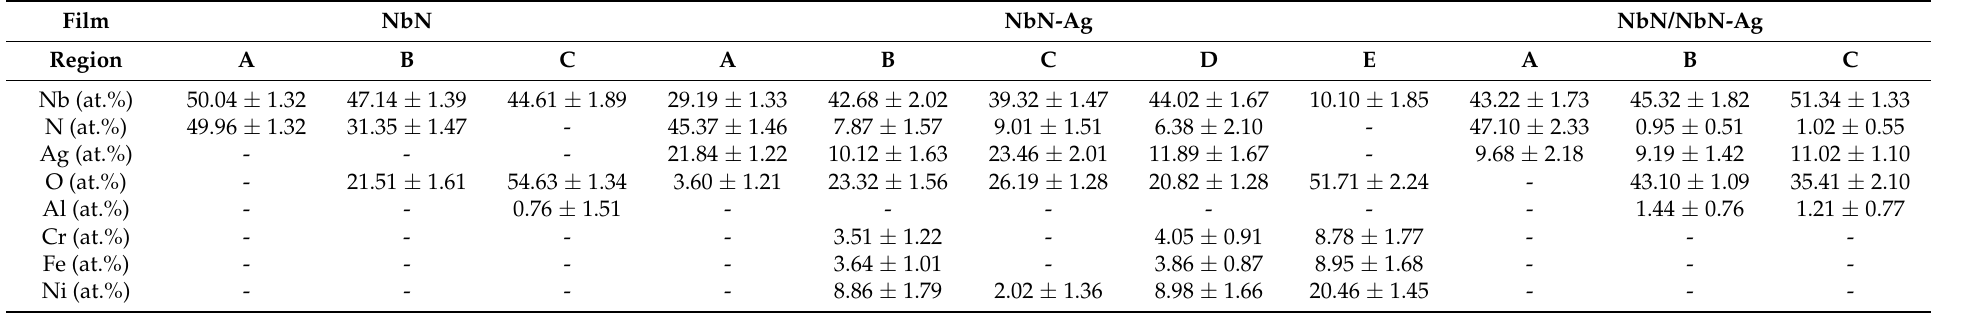
Table 3. The EDS analysis results for different positions in Figure